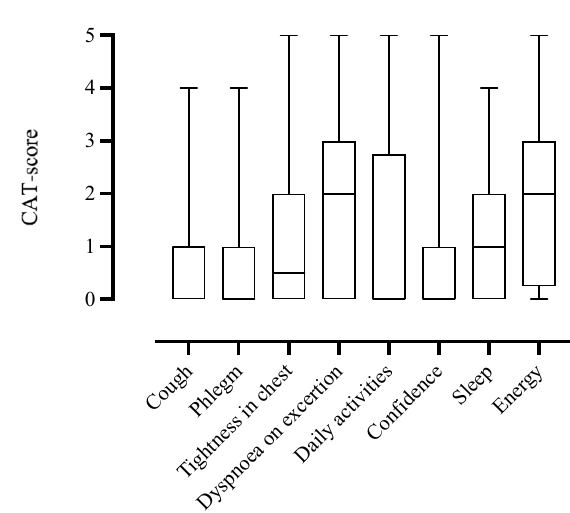
Figure 2. The CAT-score results for the overall population 3 months following hospital admission for COVID- 19. CAT-score is an eight-item questionnaire designed to assess and quantify the impact of COPD symptoms on health status. The items comprise symptoms of chough, phlegm, feeling of chest tightness, breathlessness, limitations in activities, confidence, sleep problems, and energy. Each item ranging from 0 = no symptoms, to 5 = high symptom burden. CAT-score COPD Assessment Test score, COPD chronic obstructive pulmonary